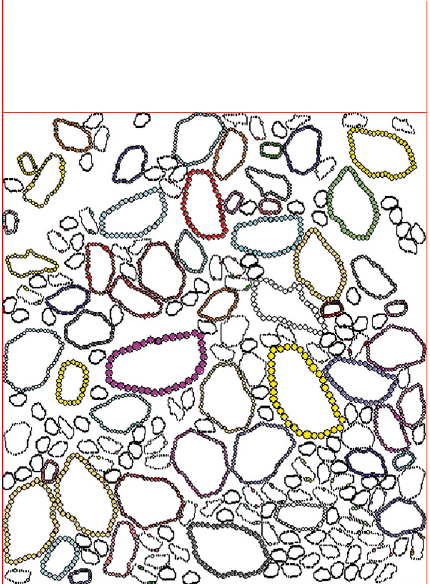
Figure 5: Coarse particles distributions within the virtual container.